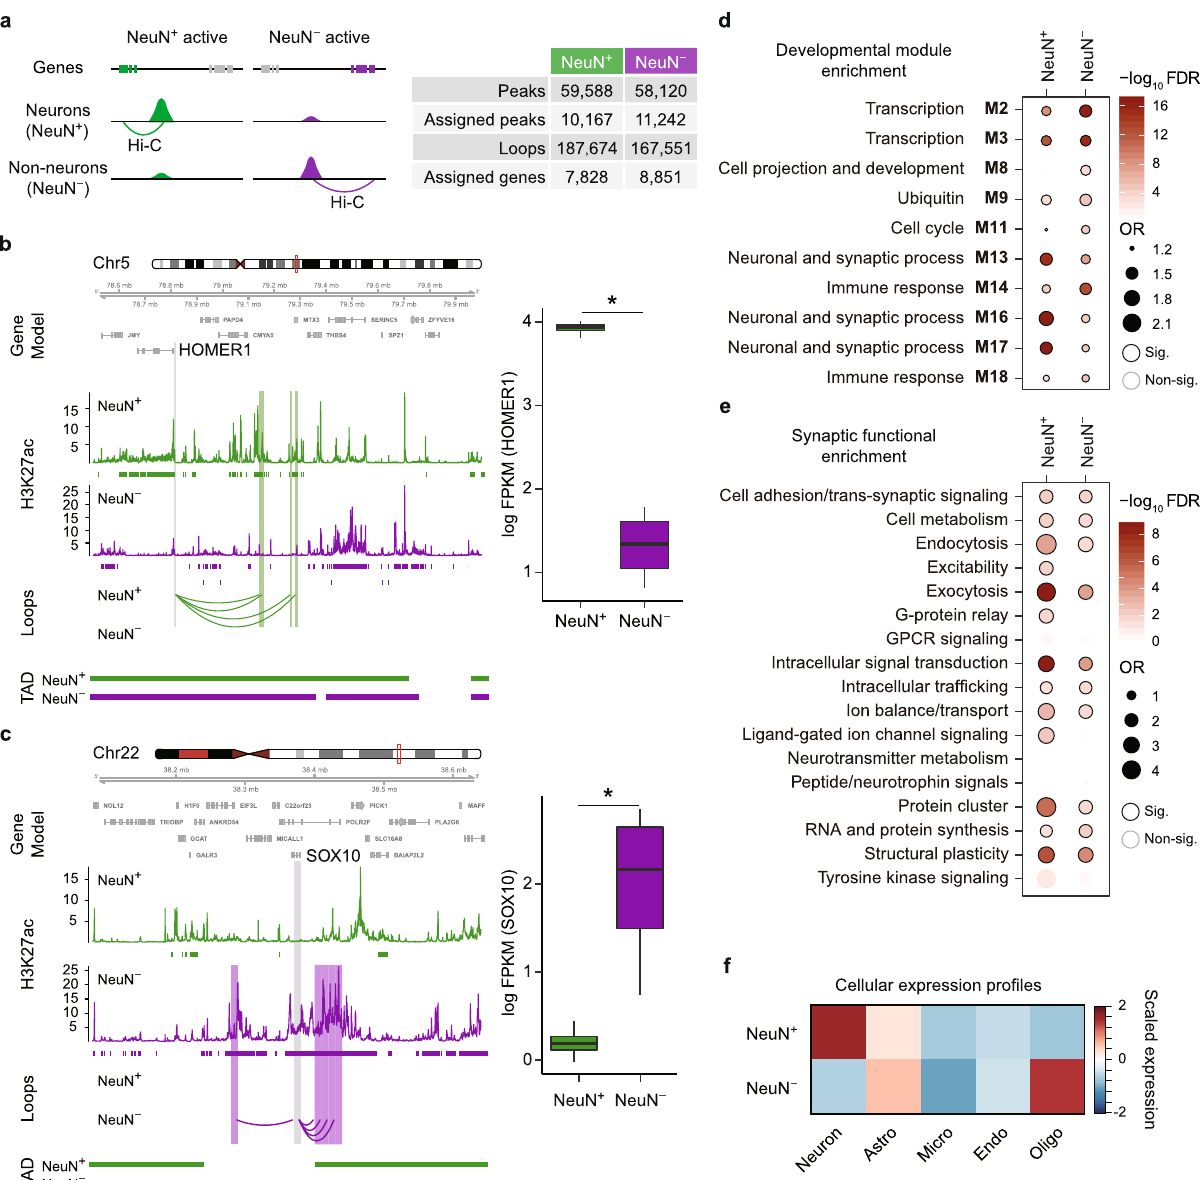
Fig. 2 Enhancer – promoter interactions in NeuN + and NeuN − cells. a (Left) cell-type-speci fi c regulatory networks were built by linking genes to NeuN + and NeuN − speci fi c H3K27ac peaks via Hi – C interactions in NeuN + and NeuN − cells, respectively. (Right) The number of cell-type-speci fi c peaks and their assigned genes in NeuN + and NeuN − cells is described. A neuronal gene, HOMER1 , is engaged with NeuN + speci fi c H3K27ac peaks via loops in NeuN + cells ( b ), while an oligodendrocyte gene, SOX10 , is engaged with NeuN − speci fi c H3K27ac peaks via loops in NeuN − cells ( c ). The regions that interact with the gene promoter (gray) are highlighted in green (NeuN + ) and purple (NeuN − ), respectively. Boxplots in the right show expression levels of HOMER1 (FDR = 7.26e − 32) and SOX10 (FDR = 1.88e − 49) in NeuN + ( n = 4) and NeuN − ( n = 4) cells, respectively. FPKM Fragments Per Kilobase of transcript per Million mapped reads. Center, median; box = Q1 – Q3; minima, Q1 − 1.5 × IQR; maxima, Q3 + 1.5 × IQR. *FDR < 0.05 calculated by DESeq2 (two-sided Wald test). Source data are provided as a Source Data fi le. d Genes assigned to NeuN + speci fi c peaks are enriched for synaptic co-expression modules, while genes assigned to NeuN − speci fi c peaks are enriched for co-expression modules involved in transcriptional regulation and immune response during neurodevelopment. Signi fi cant enrichment (Sig.), FDR < 0.05. Fisher ’ s exact test was used for statistics analysis. OR, odds ratio. e Genes assigned to NeuN + speci fi c peaks are more highly enriched for synaptic functions such as exocytosis, intracellular signal transduction, protein cluster and structural plasticity than genes assigned to NeuN − speci fi c peaks. Sig., FDR < 0.05. Fisher ’ s exact test was used for statistics analysis. f Genes assigned to NeuN + speci fi c peaks are highly expressed in neurons, while genes assigned to NeuN − speci fi c peaks are highly expressed in oligodendrocytes and astrocytes. Astro astrocytes, Micro microglia, Endo Endothelial, Oligo